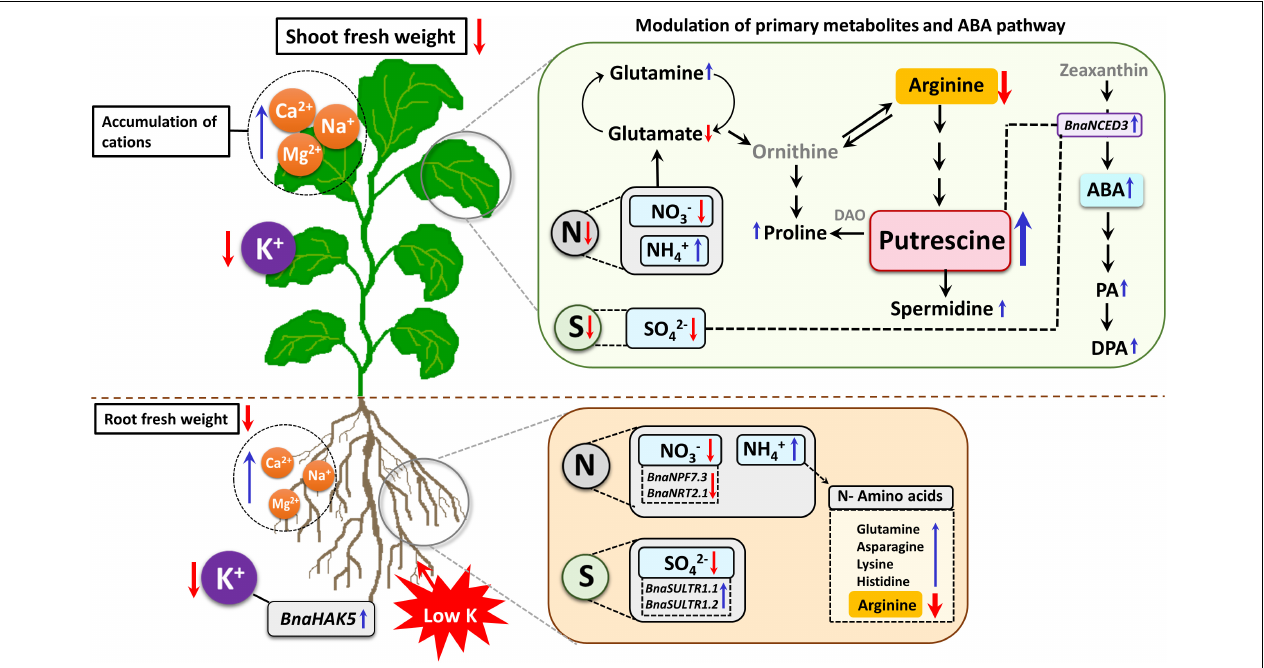
FIGURE 9 | Schematic model illustrating the response of rapeseed plants to K deprivation. K deprivation systematically affects K concentration in both roots and shoots of rapeseed which consequently induces BnaHAK5 transporter gene. Lack of K further modulates mineral nutrient status by increasing Ca, Mg, and Na levels in both roots and shoots. Moreover, concentration of nutrients, such as N and S also declined, and specific transcriptional changes were observed in their transporter genes. In both roots and shoots, major metabolic adjustments led to differential accumulation of amino acids in order to maintain the electric charge balance. These changes in amino acid levels eventually contributed to higher accumulation of polyamine putrescine (Put) which is known to interact with ABA through the induction of BnaNCED3 gene and is also involved in proline accumulation through its catabolism via diamine oxidase (DAO). (Red arrows = decrease/downregulation, blue arrows = increase/upregulation, text in gray = not measured in this study, dashed arrows = hypothesized regulation).